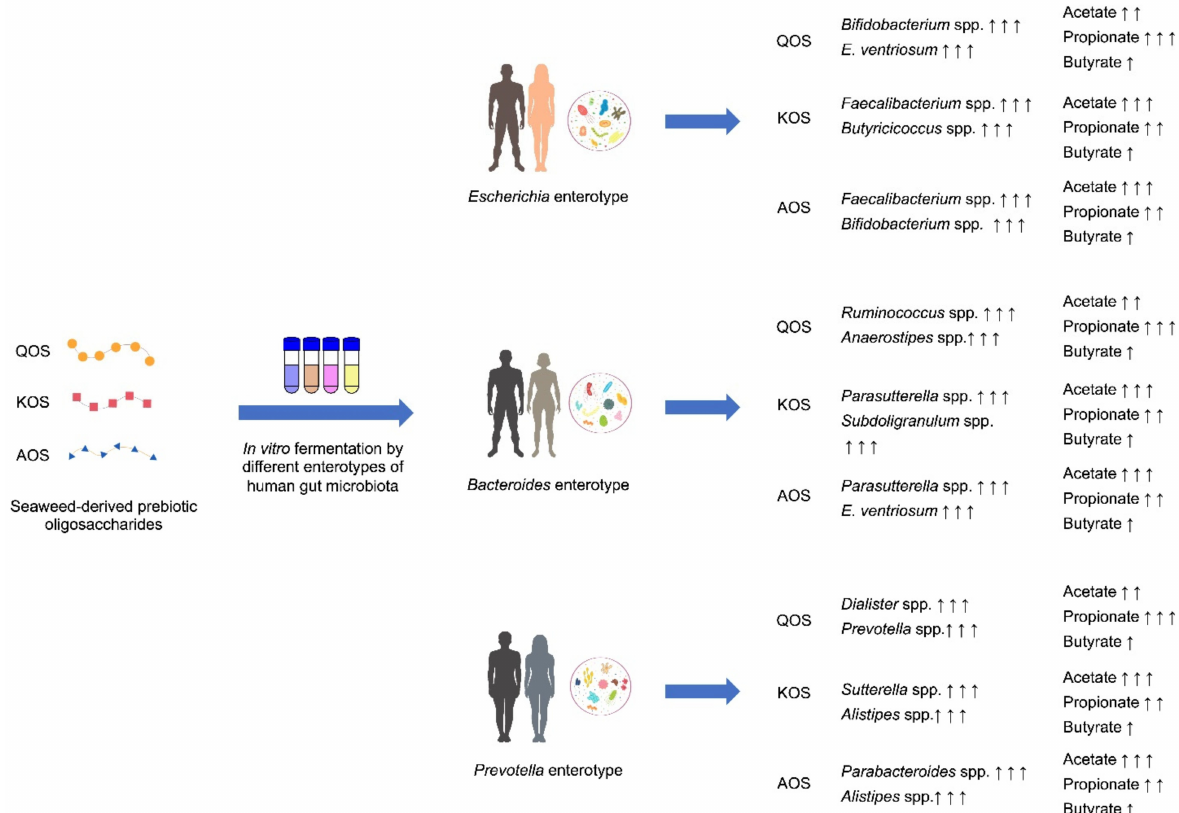
Figure 8. A graphical summary of the main findings of the present